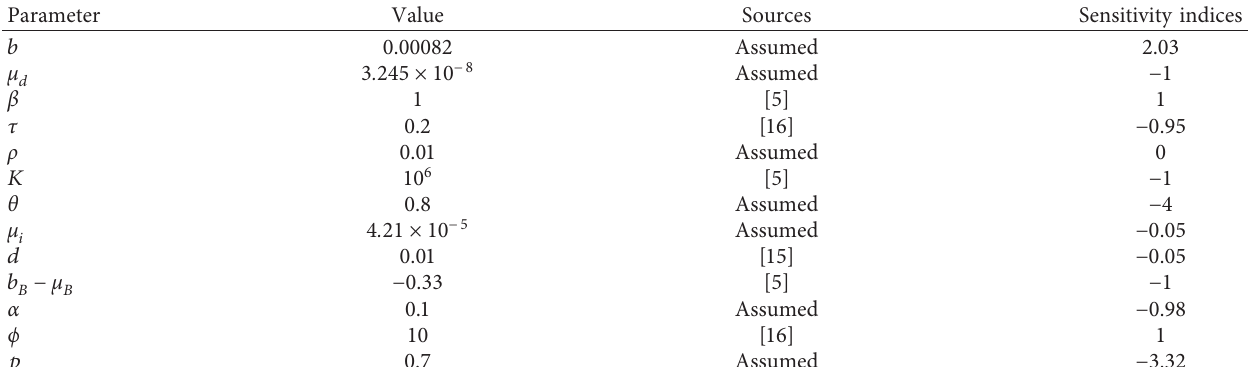
Table 2: Parameter values used for sensitivity analysis and simulation.